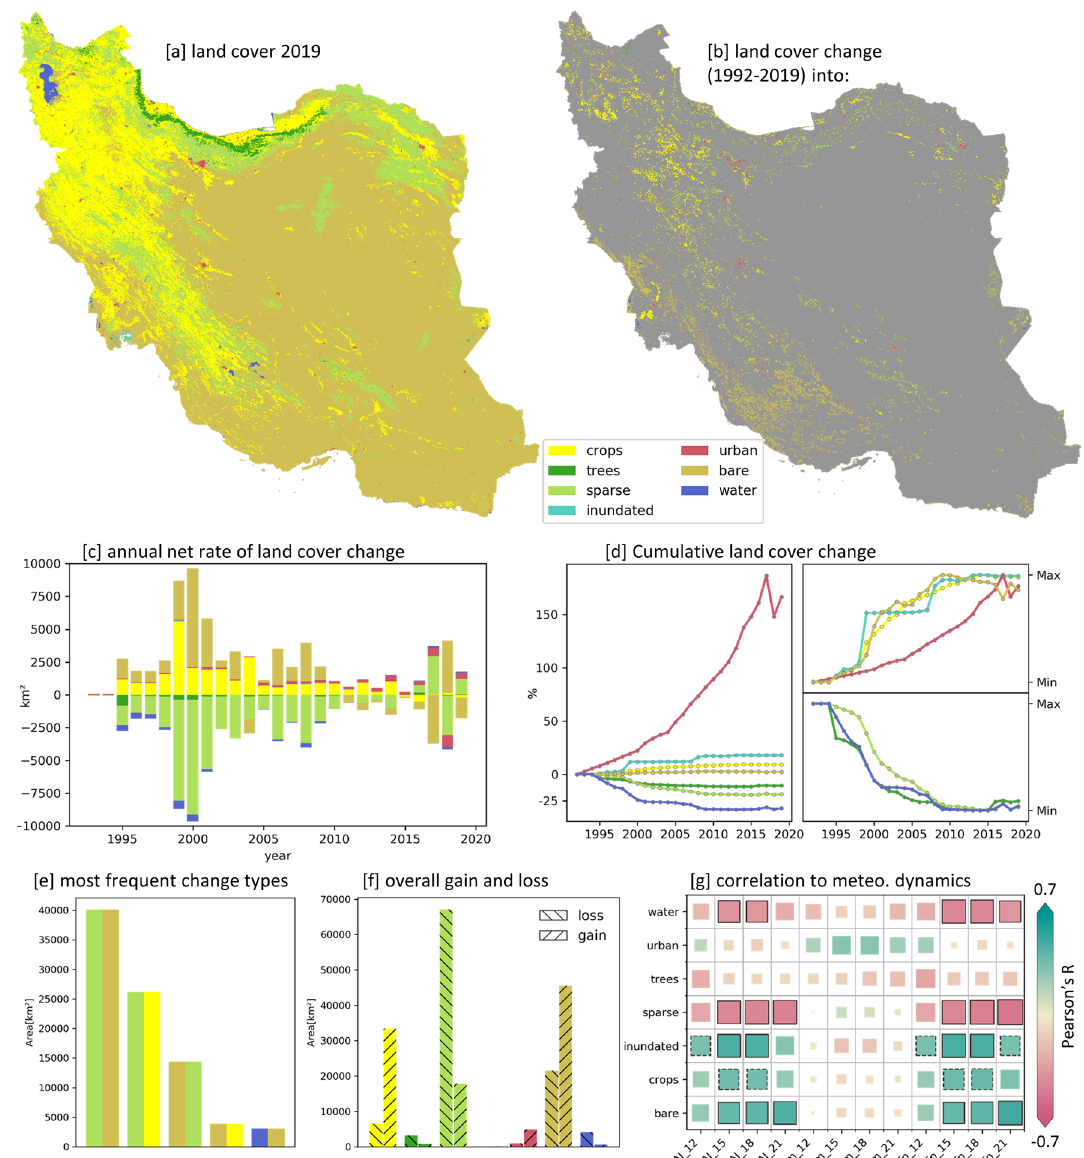
Figure 3. Land cover dynamics of Iran between 1992 and 2019. ( a ): Land cover map of 2019. ( b ): Map of the land cover that the pixel changed into from 1992–2019. ( c ): Annual net rate (annual gain - annual loss). ( d ): Cumulative land cover change. Left: change in percent related to 1992. Right: normalized change curves to long- term min and max, to highlight change intensities over time. ( e ): Five most frequent transition types. Double bars represent land cover transition from (left) to (right) land cover class. ( f ): Overall changes (gains and losses) during 1992 and 2019. ( g ): Pearson correlation between land cover annual net rate (Fig. 3c) and meteorological parameters ( ai , t 2 m , tp ) aggregated over the water year corresponding to land cover year (*_12) and over a prolonged time period including previous year’s conditions (e.g., *_15 = *_12 and previous 3 month). Maps were created using Python 3.9 (https:// www. python.